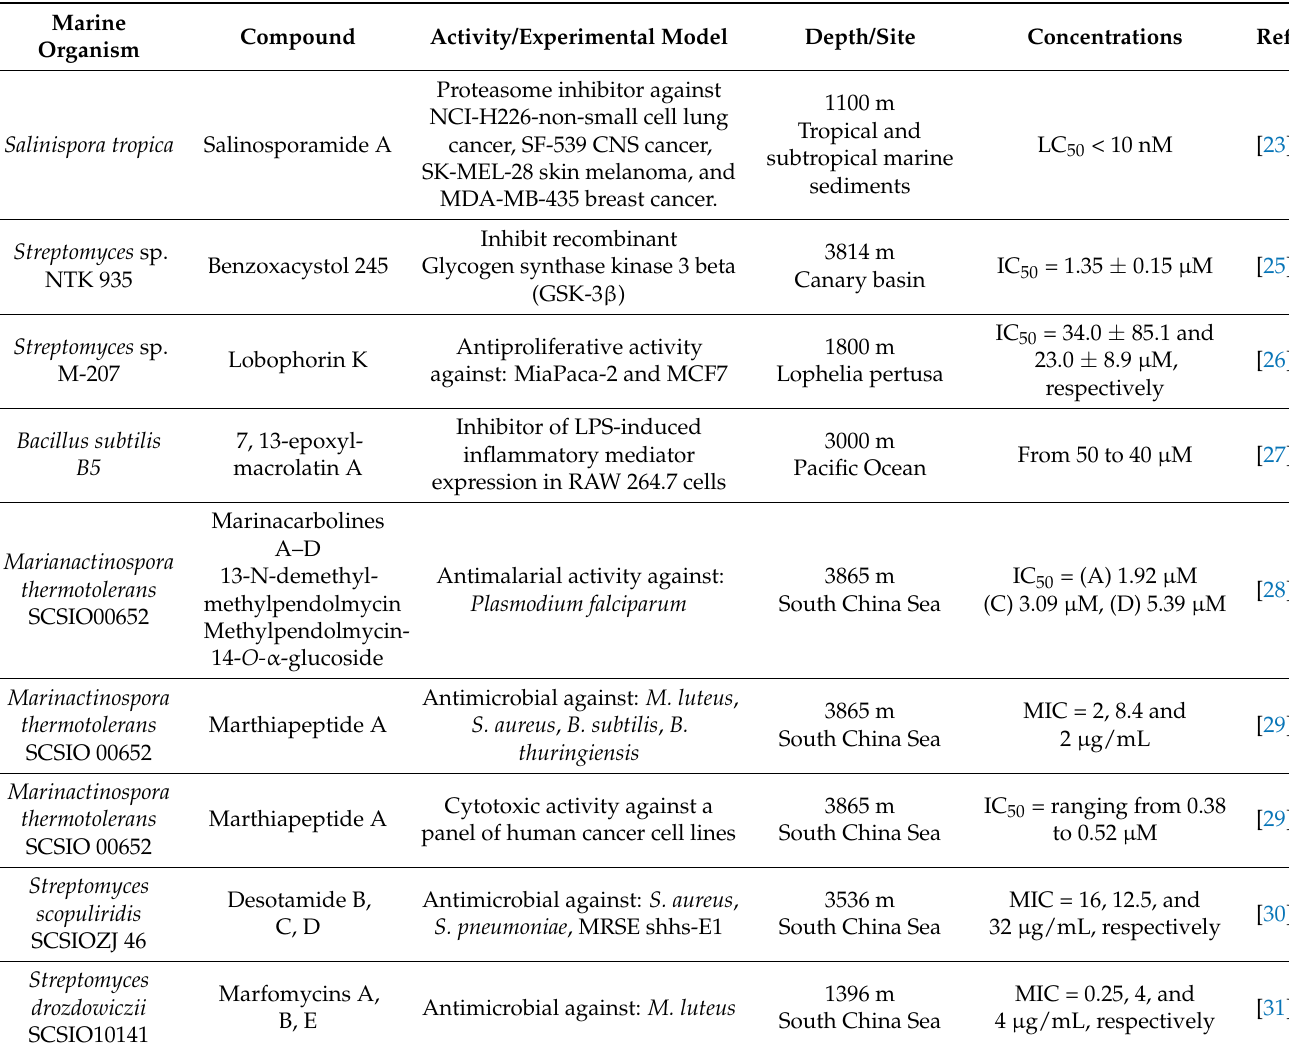
Table 1. Bioactive compounds from deep-sea